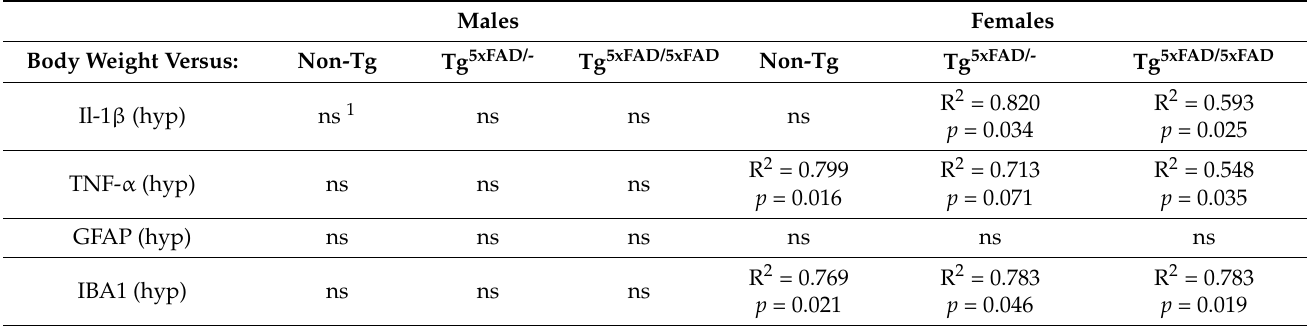
Table 1. Correlations between body weight and hypothalamic neuroinflammatory markers in 5xFAD mice at 6 months of age. Males Females Body Weight